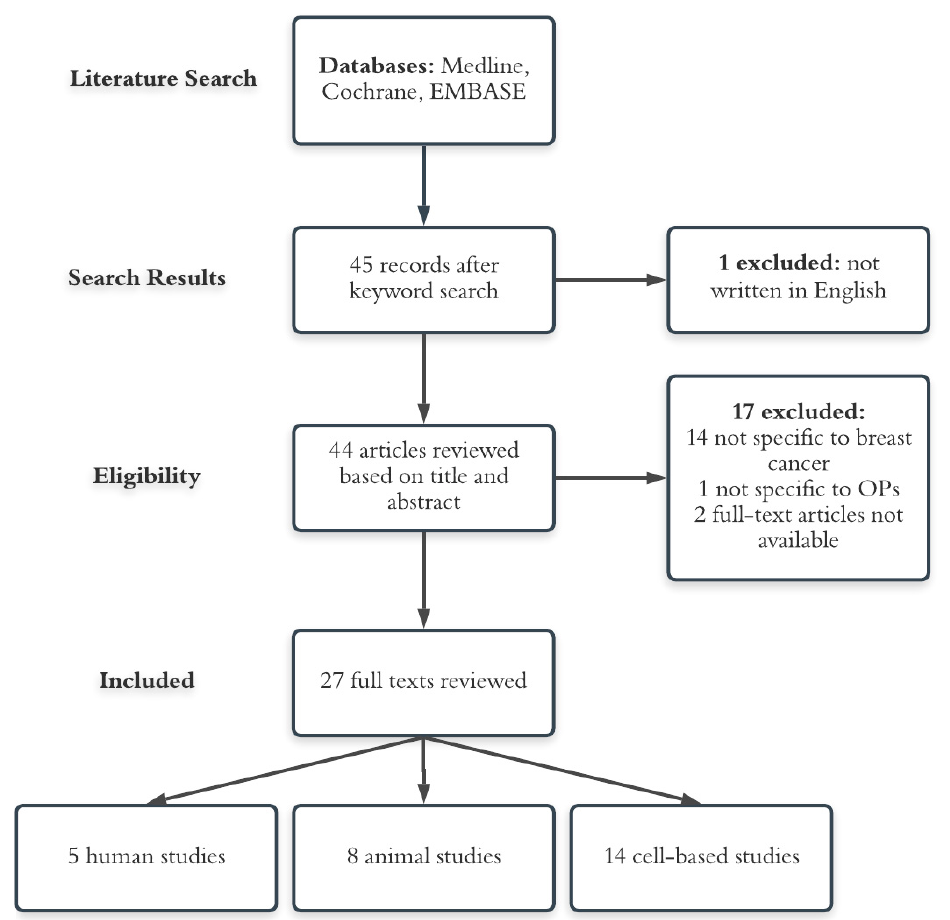
Figure 1. Flow chart summarizing study identification and selection process.